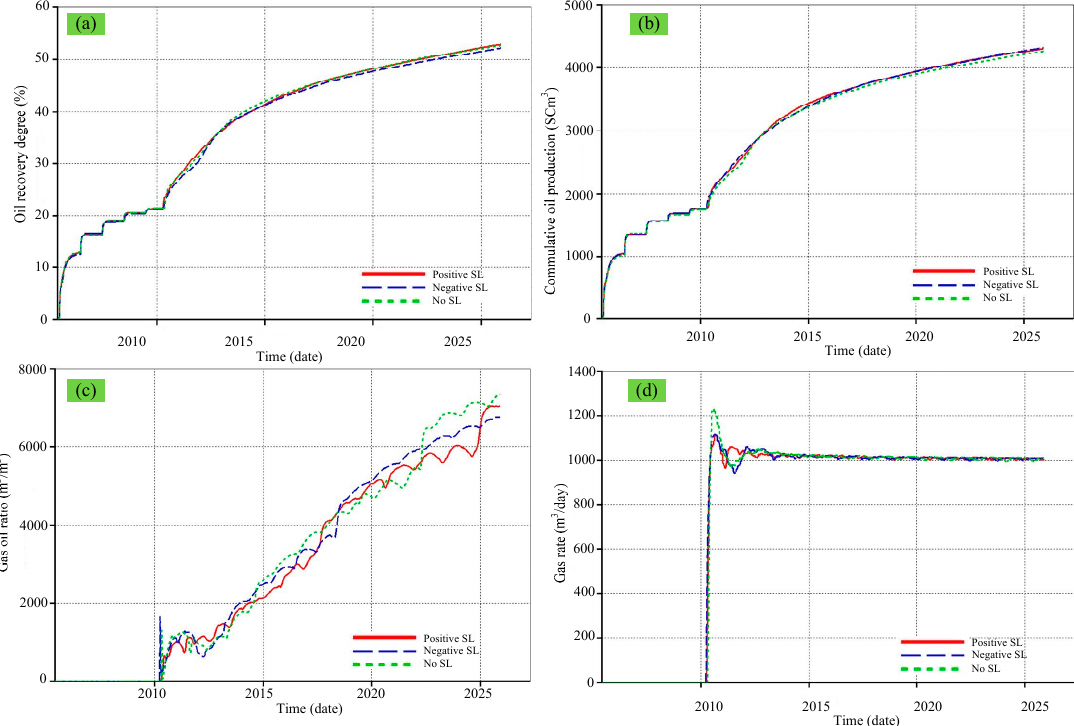
Figure 9. Comparison of production indicators under different stratigraphic layering. ( a ) Recovery degree; ( b ) cumulative oil production; ( c ) gas-oil ratio; and ( d ) gas production rate. Table 14. Dynamic production indicators under di ff erent stratigraphic layering